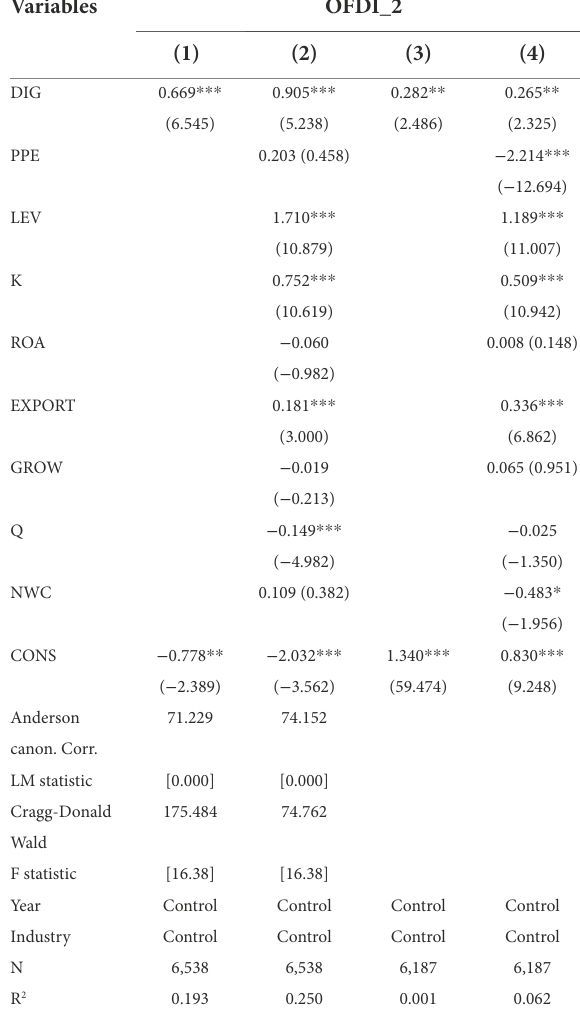
TABLE 11 Regression results of enterprises in the eastern, central and western regions.